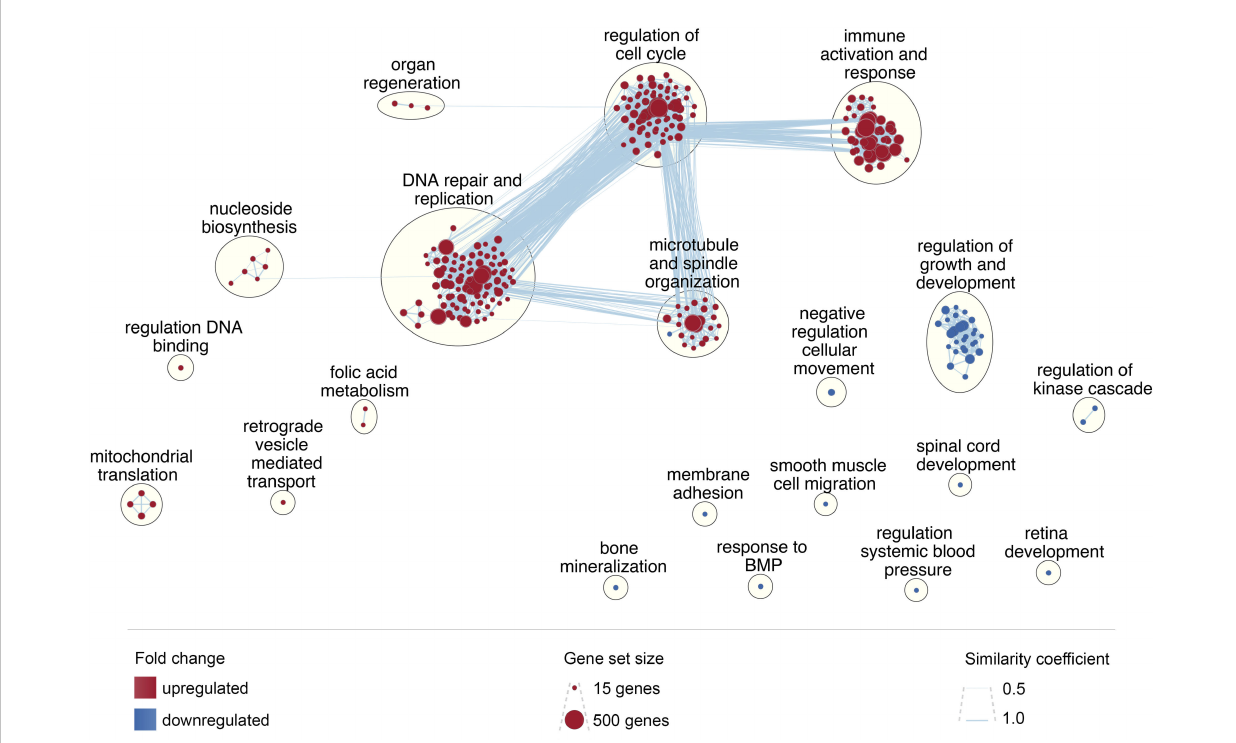
FIGURE 9 Enrichment map of enriched biological processes. Enrichment map was created in Cytoscape using GSEA results; each node represents a gene set; node size re fl ects gene set size; node color re fl ects upregulation (red) or downregulation (blue); clusters were generated using Community Cluster (GLay) Annotation Set in the AutoAnnotate plugin, with minor adjustments to improve language; edges, shown as blue lines, re fl ect gene set overlap between nodes; edge width re fl ects the similarity coef fi